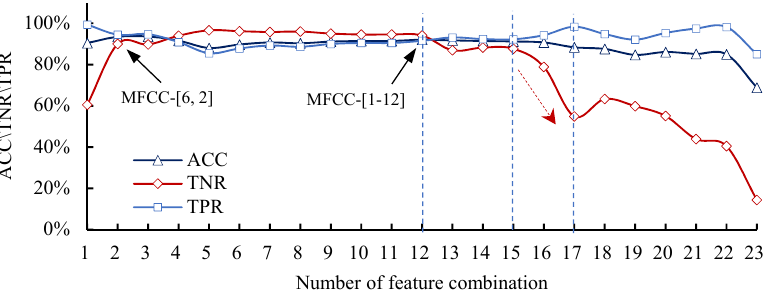
Figure 12. ACC, TNR, and TPR of 23 AIEFPC models obtained by different combinations of MFCC are selected as the AE sample feature on the sample set of coal samples ad8-5 and bd8-5.